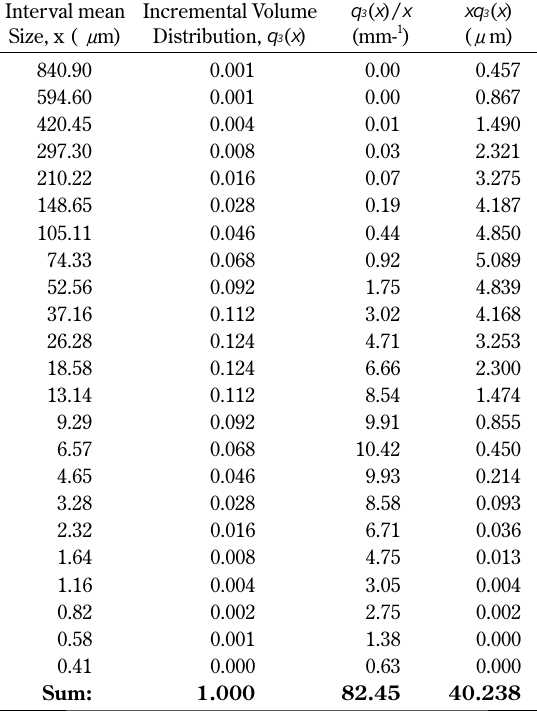
Table A2 Estimation of average sizes from volume